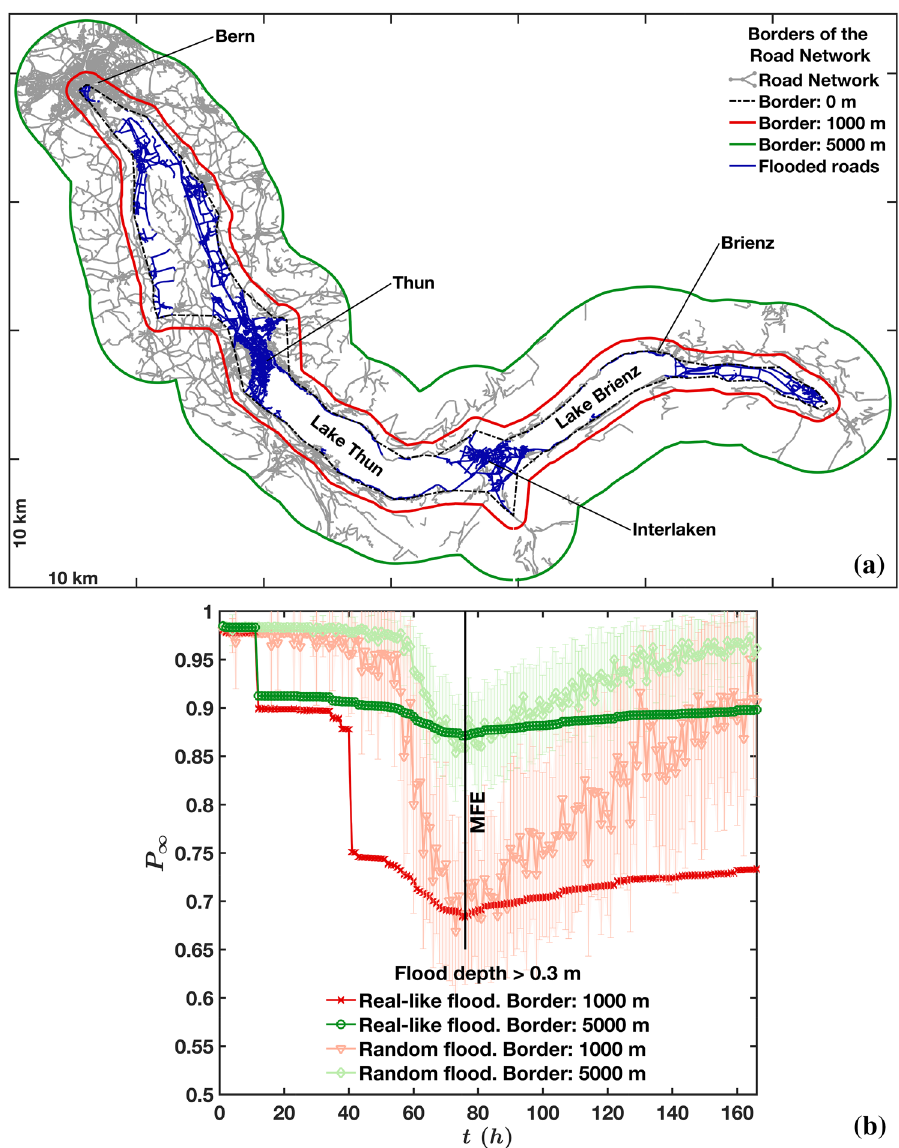
Figure 1. ( a ) Definition of borders. Given the set of endpoints (nodes) of the flooded roads at the maximum flood extension, a tight 2-D boundary 53 surrounding those points was drawn. The boundary was created with a shrink factor 53 equal to s f = 0.5 , which is between a convex hull ( s f = 0 ) and the “tightest single-region boundary” ( s f = 1 ). That boundary corresponds to the dash-dot line called “border: 0 m”. Larger boundaries, corresponding to “border: 1000 m” and “border: 5000 m”, were created by radially expanding 54 the “border: 0 m” by a distance of 1000 and 5000 m, respectively. ( b ) Evolution during the flood of the fraction P ∞ of nodes belonging to the giant connected component computed for both real-like floods 51 and randomly generated floods and for both the 1000 and 5000 m-borders shown in ( a ). The curves representing the random floods were computed by averaging the values of 20 realizations. Here, they are shown with 1-standard deviation error bars. More precisely, those average values resulted from the arithmetic mean performed over the 20 values of P ∞ (related to the 20 realizations of random floods), at each time-step, while the vertical bars around the average values represented the standard deviation performed over the 20 values of P ∞ , still at each time step. Therefore, both mean and standard deviation (1-std) of the 20 values of P ∞ are here shown, for each time step (obviously, those 20 values are different at each time step). This figure was produced with Matlab 55